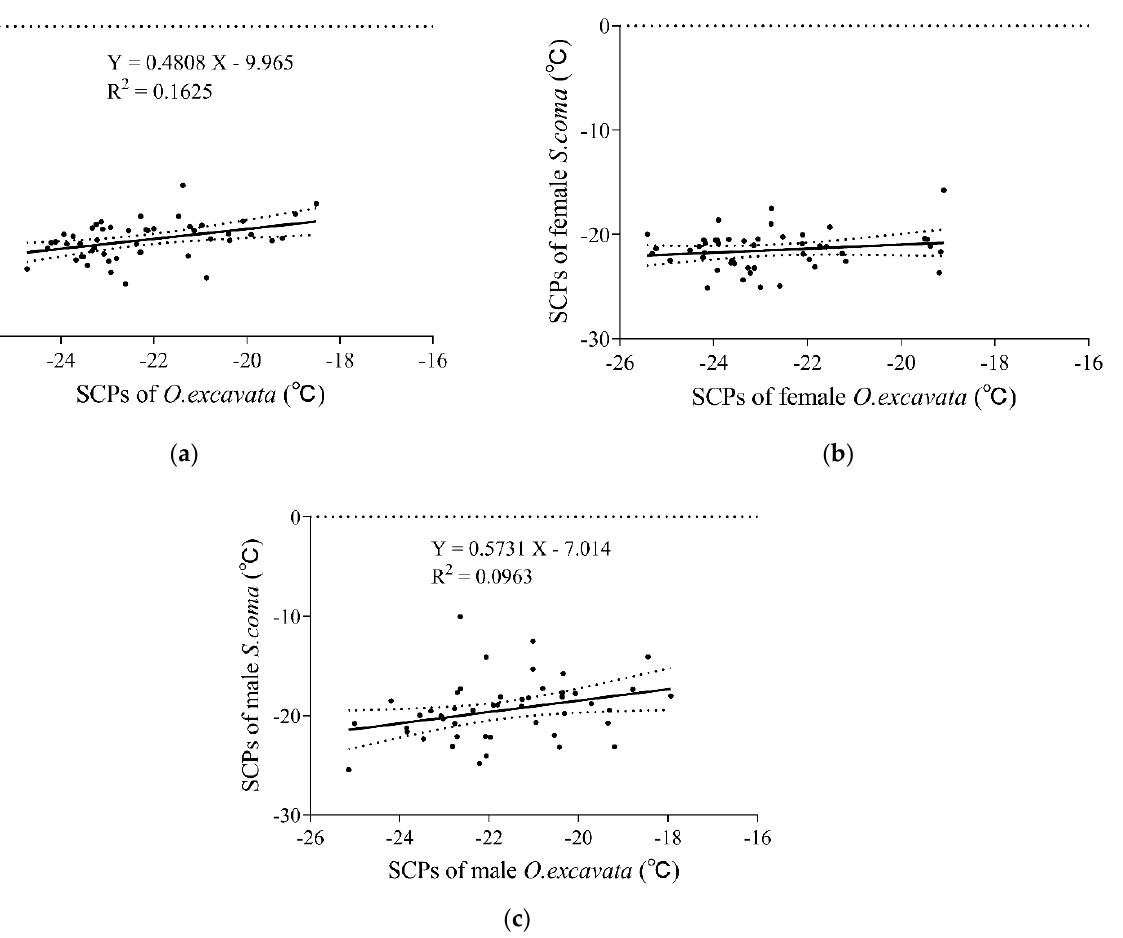
Figure 2. Influence of SCPs of O. excavata on SCPs of S. coma in ( a ) general, ( b ) females, and ( c ) males. Points show the raw data. Solid lines represent the result of the general linear model, while dashed lines represent the 95% confidence bands. Figures with a regression equation denote a significant ( p < 0.05) linear regression and without otherwise.